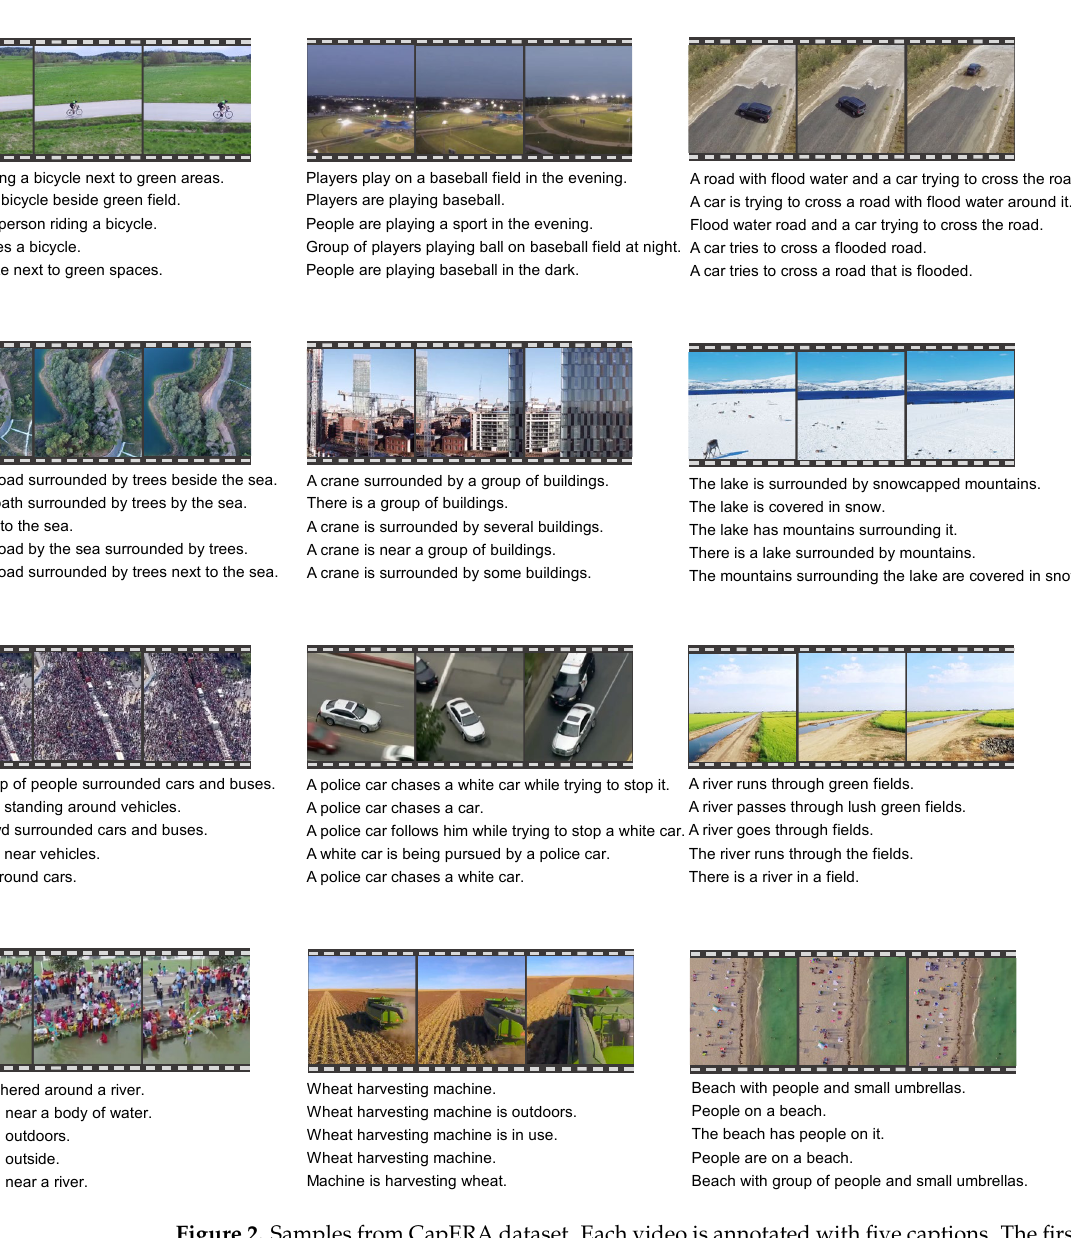
Figure 2. Samples from CapERA dataset. Each video is annotated with five captions. The first caption is manually annotated by a human, while the rest are automatically generated. Table 1. Statistics from CapERA